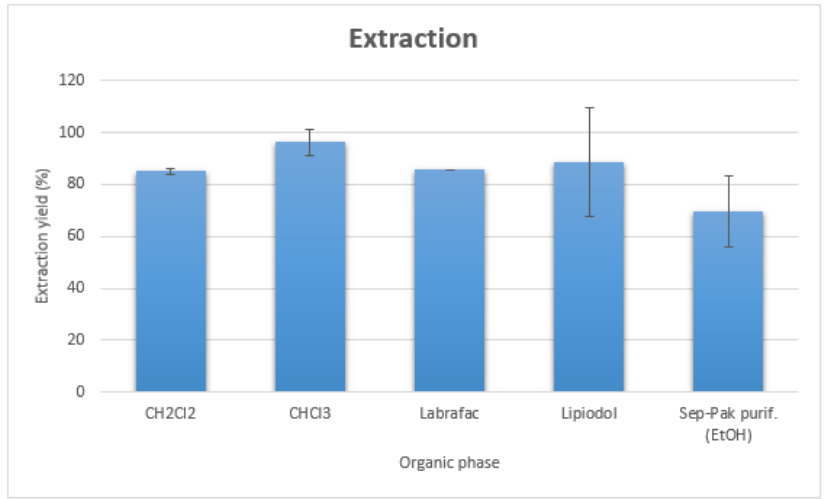
Figure 3. Extraction yields of 90 Y-Hinokitiol in various organic phases.